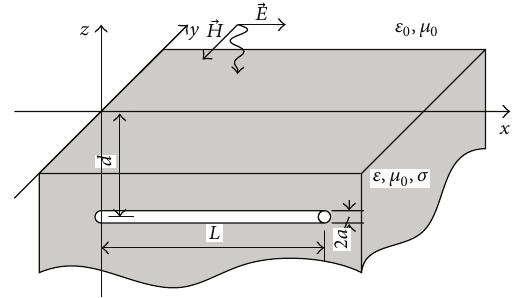
Figure 1: A horizontal thin wire buried in a lossy medium.